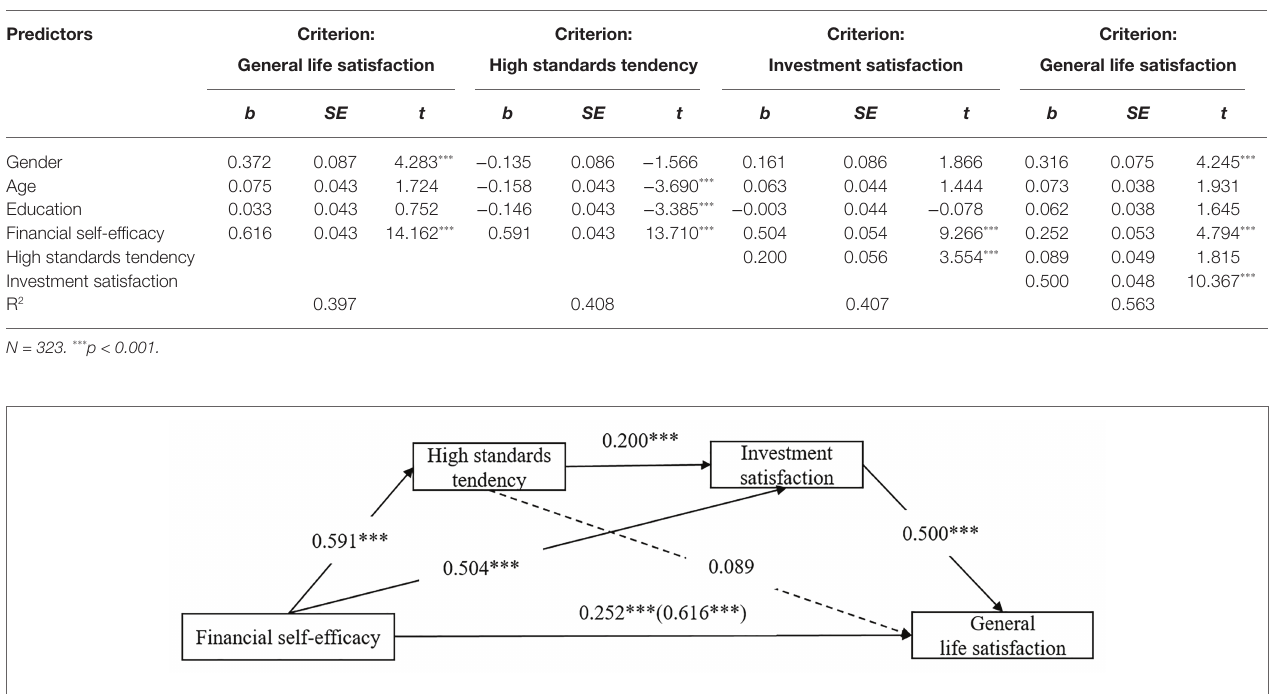
FIGURE 2 | Effect of financial self-efficacy and general life satisfaction via high standards tendency and investment satisfaction. *** p <